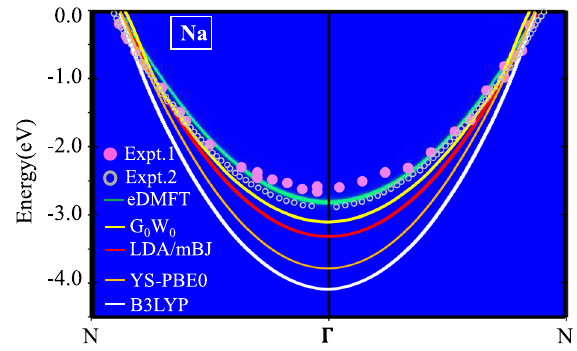
Fig. 1 Band structure of elemental Na as computed in LDA, mBJ, G 0 W 0 , YS-PBE0, B3LYP, and eDMFT. Dots in pink and gray indicate angle-resolved-photoemission(ARPES) data from earlier experiment by Lyo and Plummer 20 and more recent experiment by Potorochin et al. 48